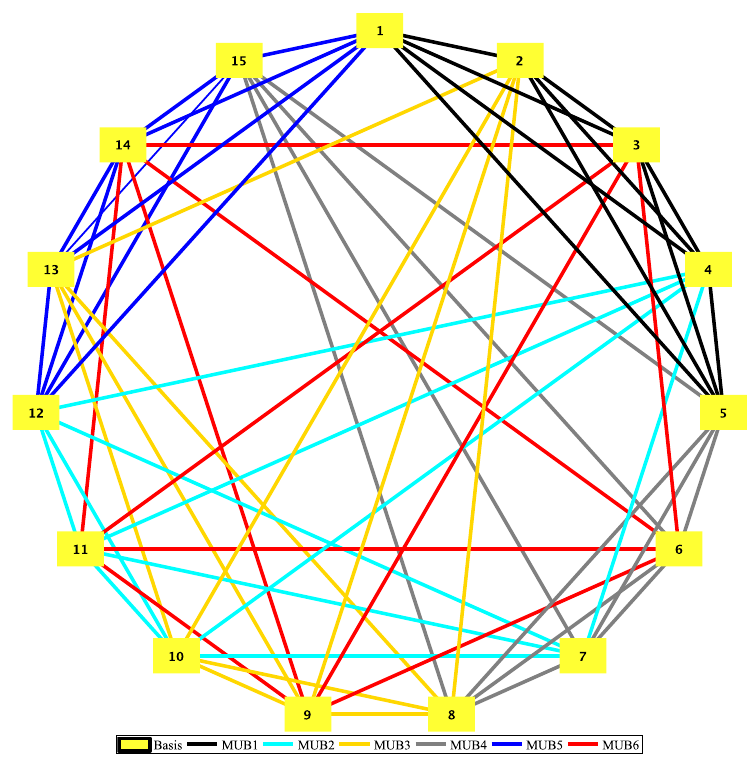
Figure 1. Regular graph for two qubits. Each vertex represents a basis; two vertices connected with a single edge imply that the corresponding bases are mutually complementary. The subgraphs formed by edges of the same color form a complete set of mutually unbiased bases.